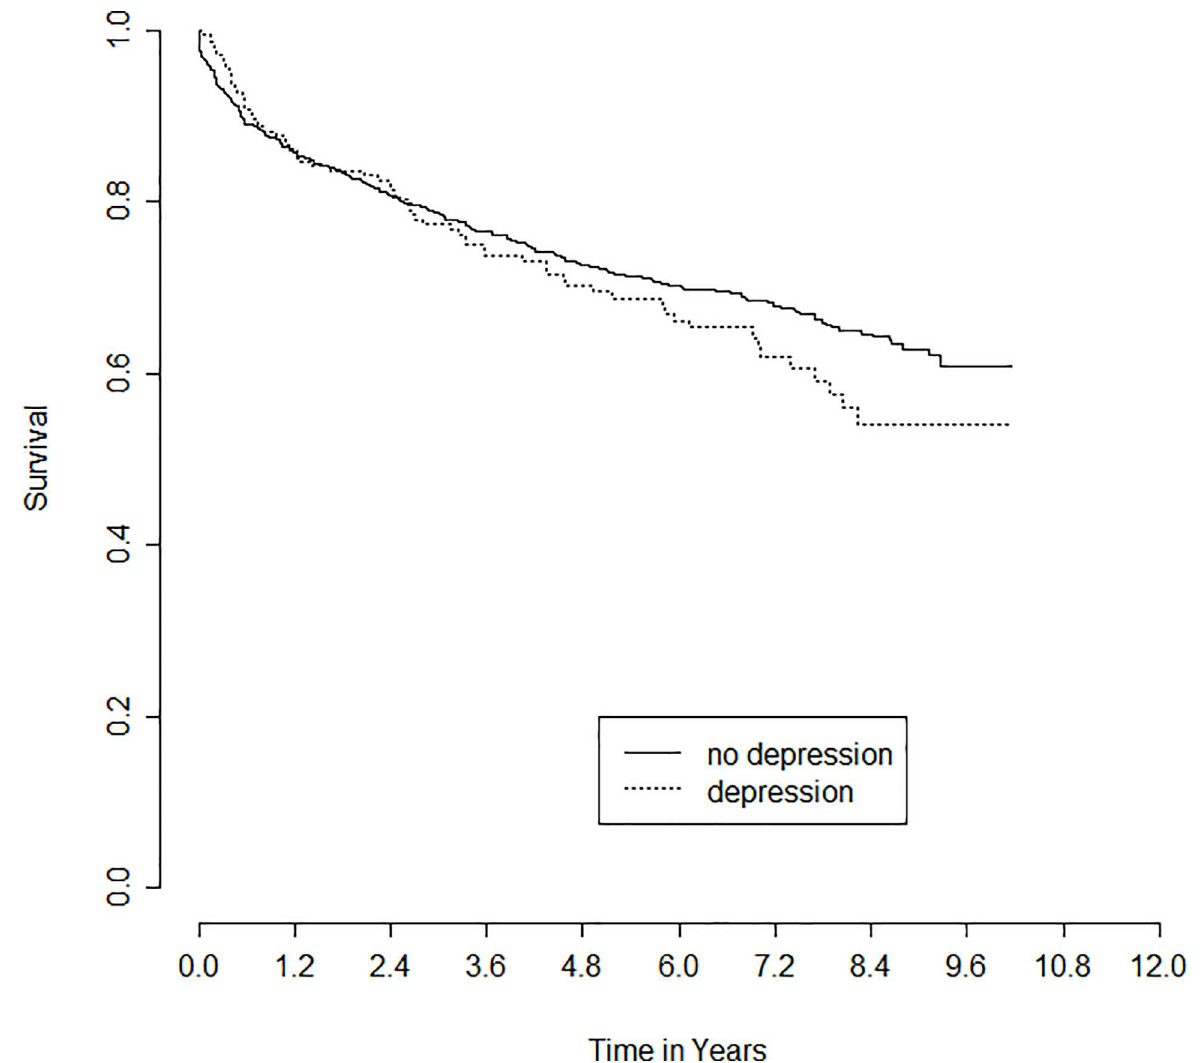
Fig 1. Survival by Pre-Transplant Depression